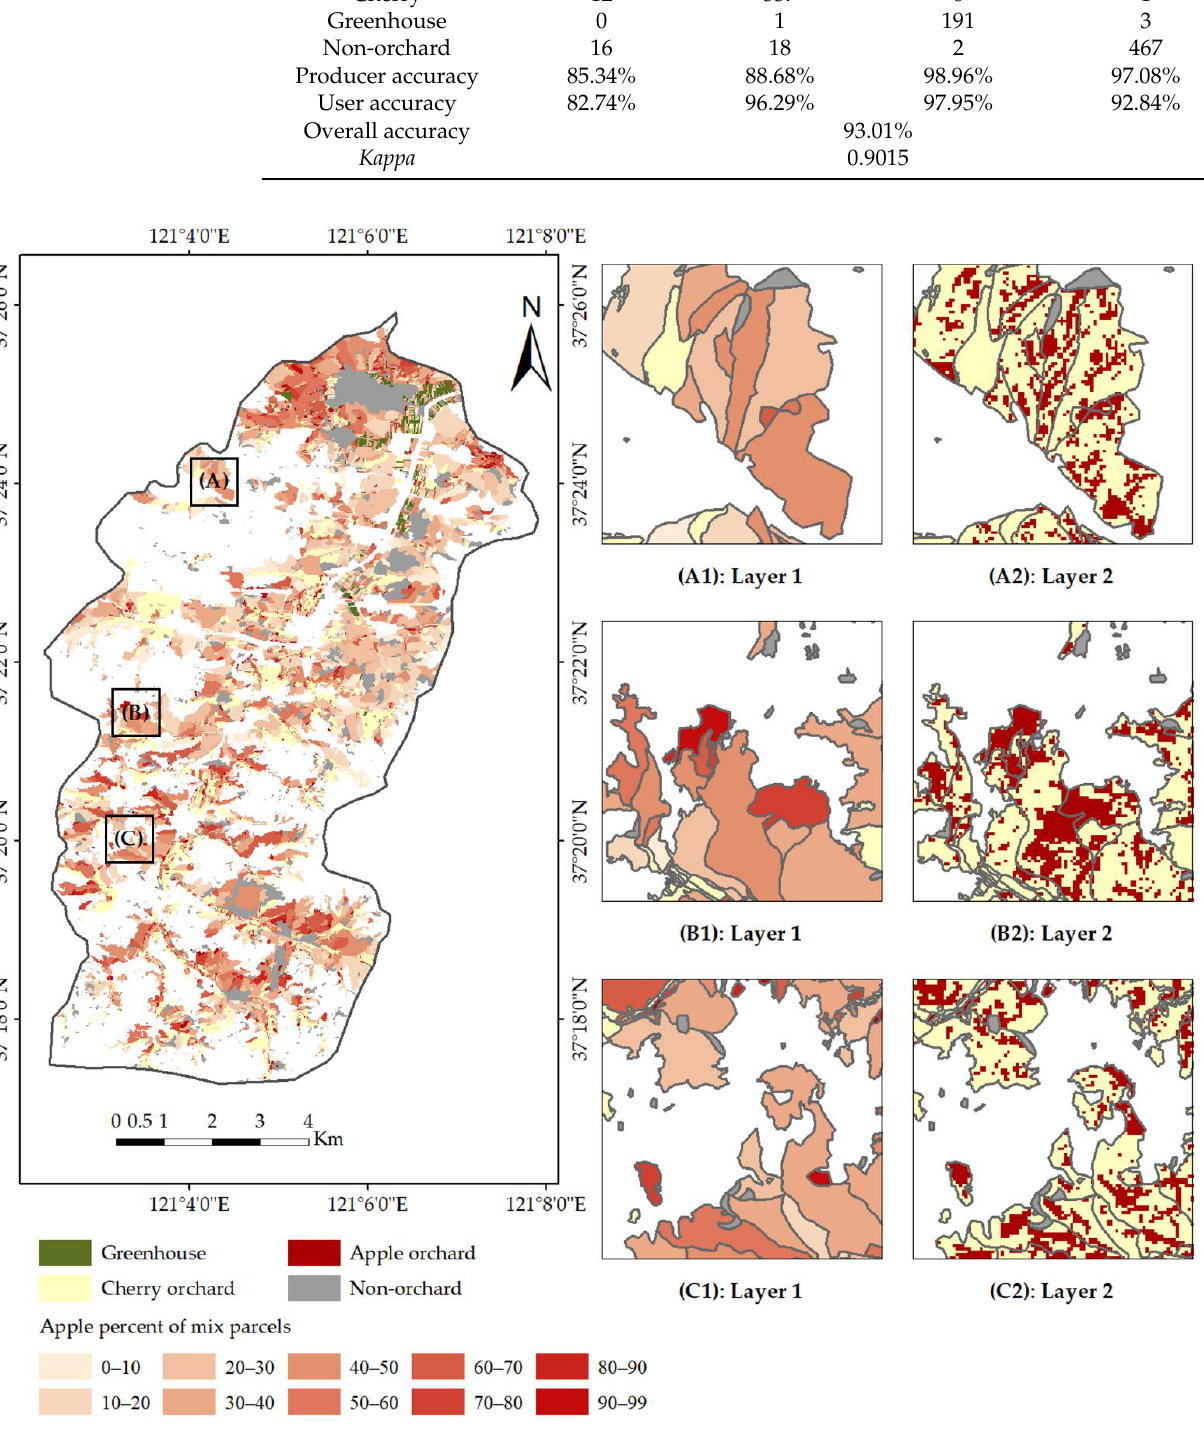
Figure 13. Parcel category fill results. ( A – C ) are subregions of the study area. In the mixed parcels, both cherry and apple trees are planted. For the mixed parcels, we use different colors to represent them according to the proportion of apple trees in them. The darker the color, the higher the proportion of apple trees. Three subregions with many mixed parcels were selected to show the two-layer structure of mixed parcels, which illustrates the effectiveness of the filling strategy. Based on the final results, we reviewed statistics on the planting information in the study area. The planting area of crops comes from two aspects: the area of pure orchard parcels and the area of orchard in mixed parcels, which can be obtained by multiplying the area of the mixed parcel by the proportion of orchard within it. The apple orchard area in the study area is calculated as 711.8 hectares, and the cherry orchard area as 1968.2 hectares.